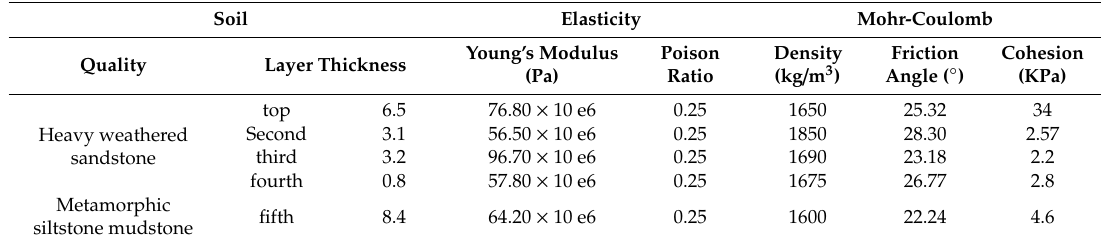
Table 1. Geotechnical properties of the